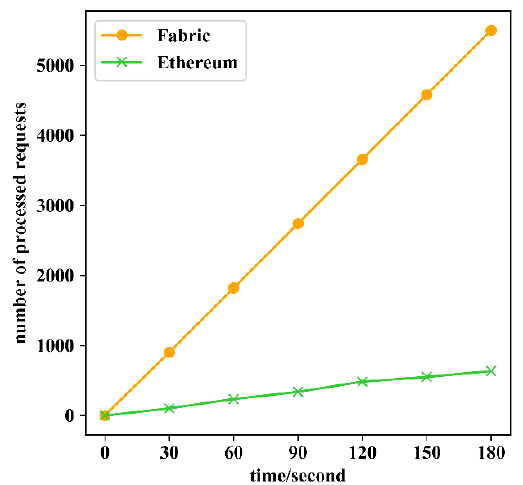
Figure 7. Comparison of the number of access control requests processed.